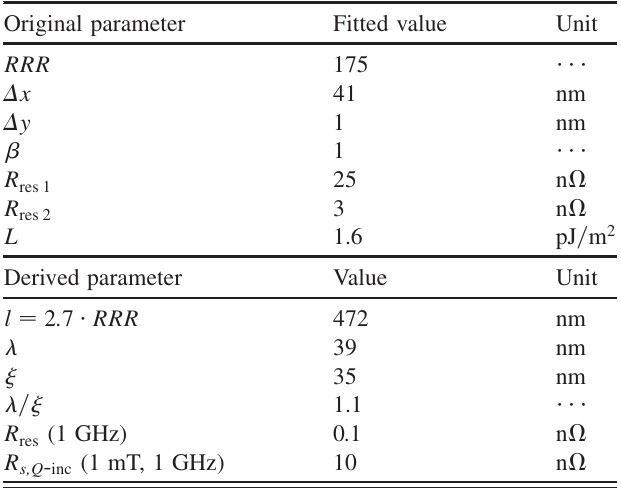
TABLE III. Fitted original and derived parameters obtained by (cid:6) 2 minimization of the collective data. Original parameter